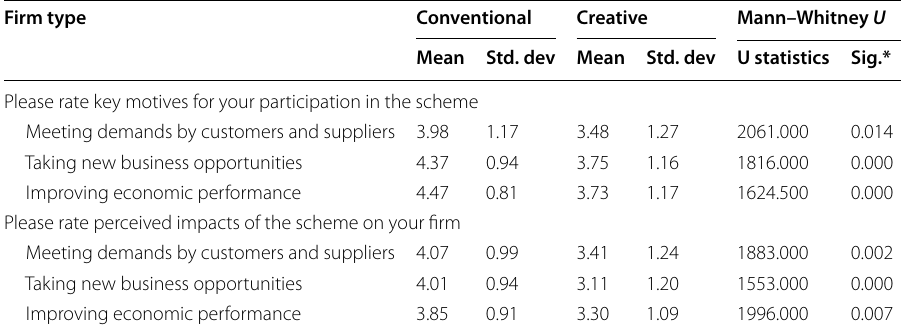
Conventional firms N Please indicate the level of agreement with each statement on a scale: 1